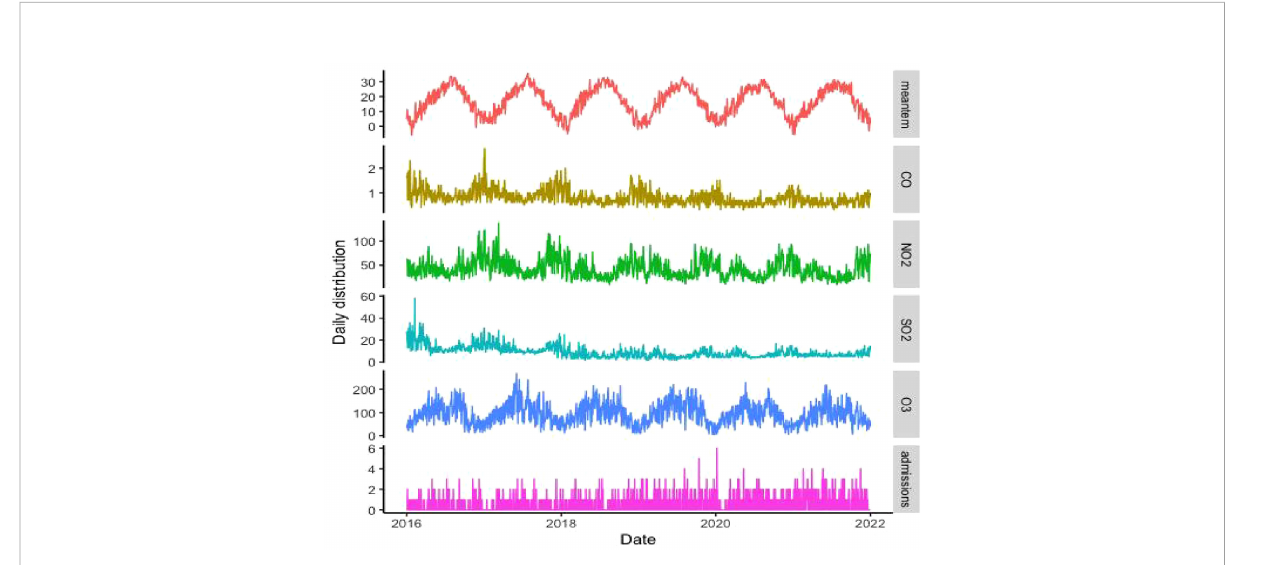
FIGURE 1 The time series of gaseous pollutants, mean temperature, and hospitalizations for SS from 2016 to 2021 in Hefei.